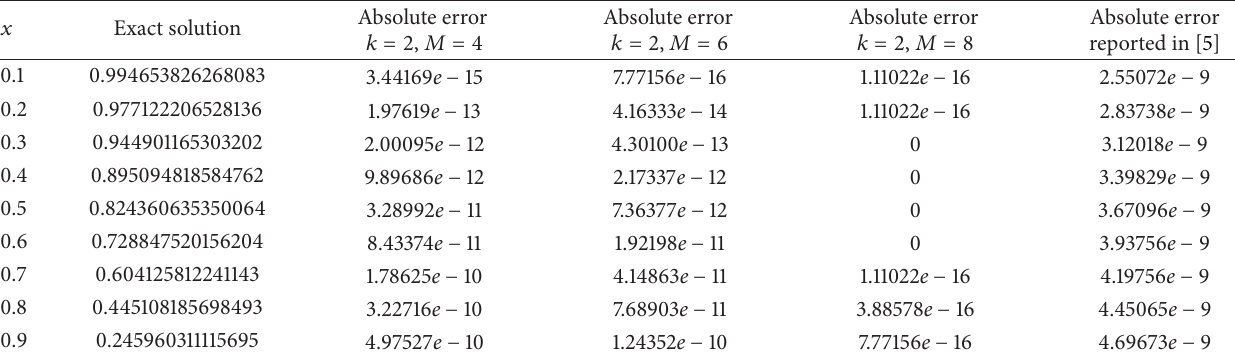
Table 3: Comparison of numerical results for Example